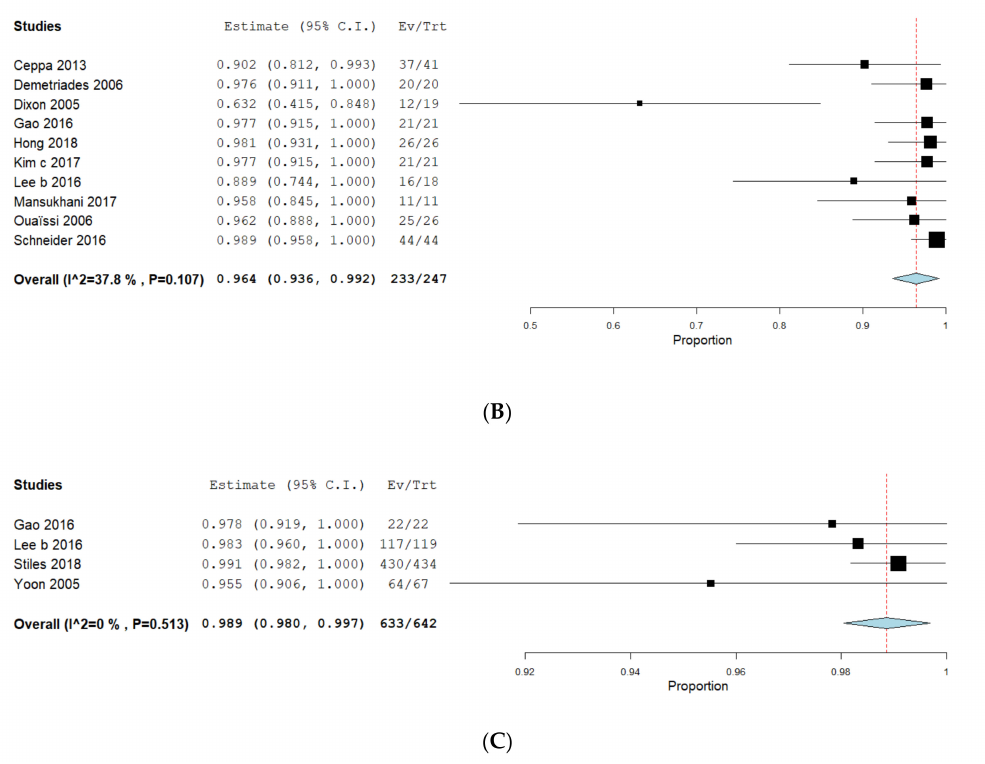
Figure 2. Complete resection in endoscopic and surgical intervention. Proportions of meta-analyses were calculated and shown as forrest-plots for EA ( A ), SA ( B ) and PD ( C ). Pooled R0 rates were calculated to obtain a proportion with a 95% confidence interval (CI). The binary random e ff ects model (DerSimonian–Laird) was used for EA and SA and a fixed e ff ect model with inverse variance weighting was used for PD. EA: endoscopic ampullectomy, SA: surgical ampullectomy, PD: